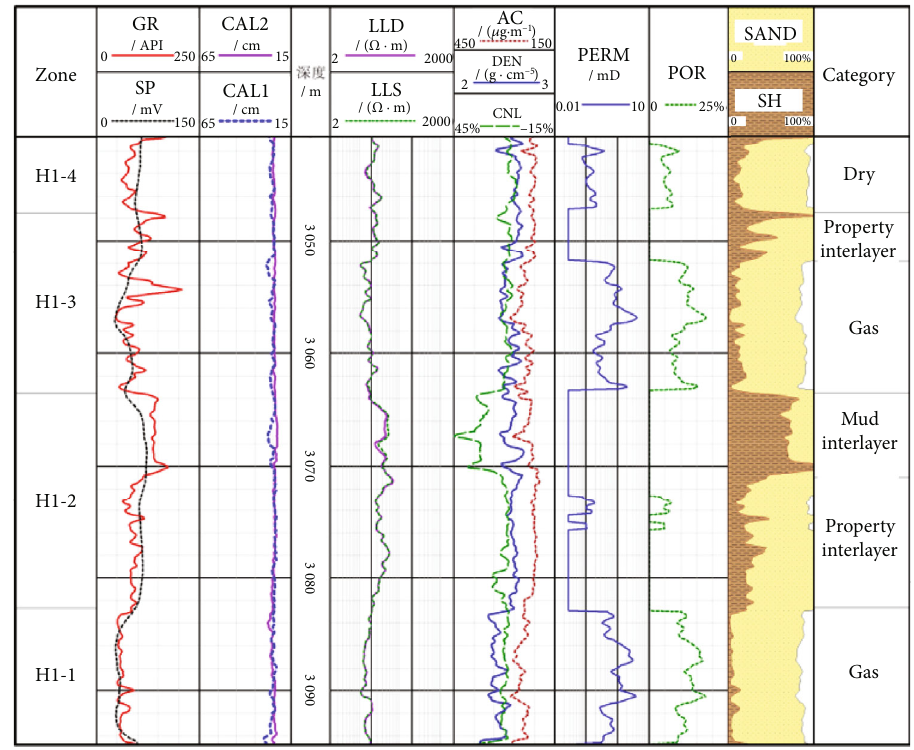
Figure 1: The characteristics of the H-1 zone in the Dongsheng gas fi eld